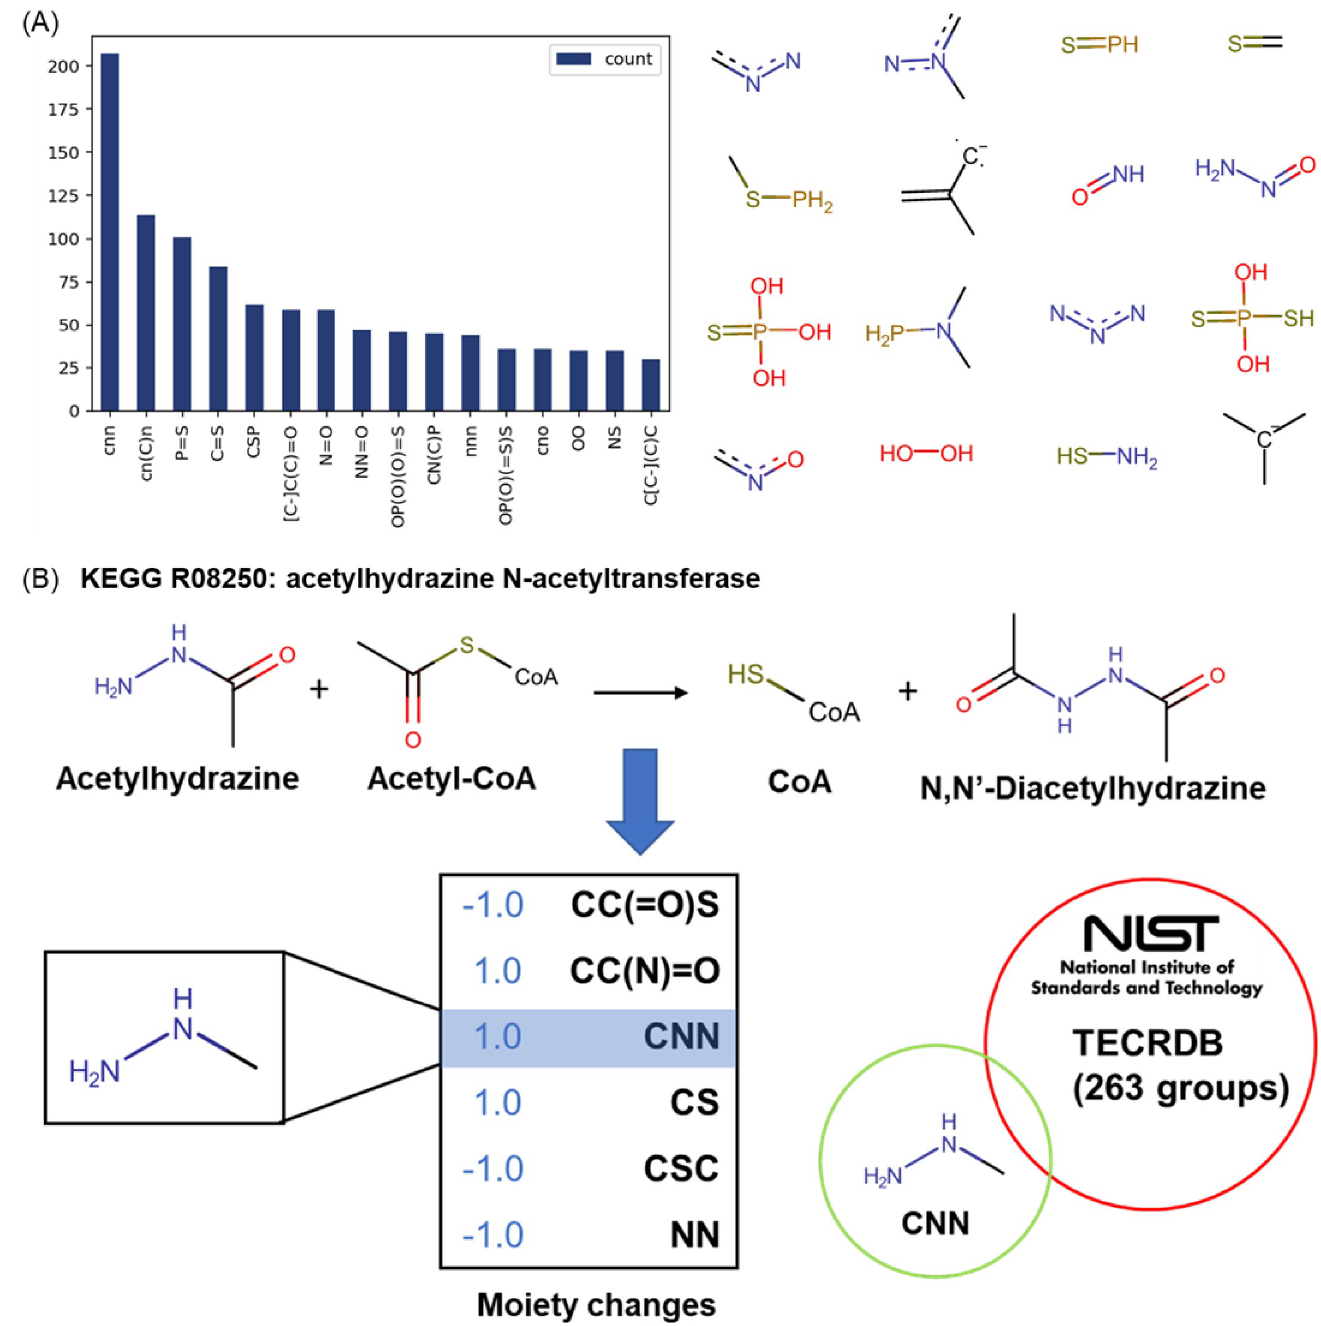
Fig 3. Unique substructure covered by dGPredictor. (A) Unique substructures in the 14.7% metabolites missed by previous GC method. Here the count indicates the occurrence of such substructures in metabolites (B) Example of a reaction with groups (i.e., group “C-N-N”) missing from the 263 groups from TECRDB. https://doi.org/10.1371/journal.pcbi.1009448.g003 [28] by maximizing the log of the posterior distribution in Bayesian ridge regression yields a parameter α of 9.023 10 − 4 . The standard deviation of Δ G o in dGPredictor is computed as s ¼ g ffiffiffiffiffiffiffi p ¼ 33 : 29 kJ/mol. As shown in Fig 2B, the Δ a (cid:0) 1 G o contributions of 1,643 moieties are well- g determined as their estimates for 99% fall within three standard deviations of their mean.